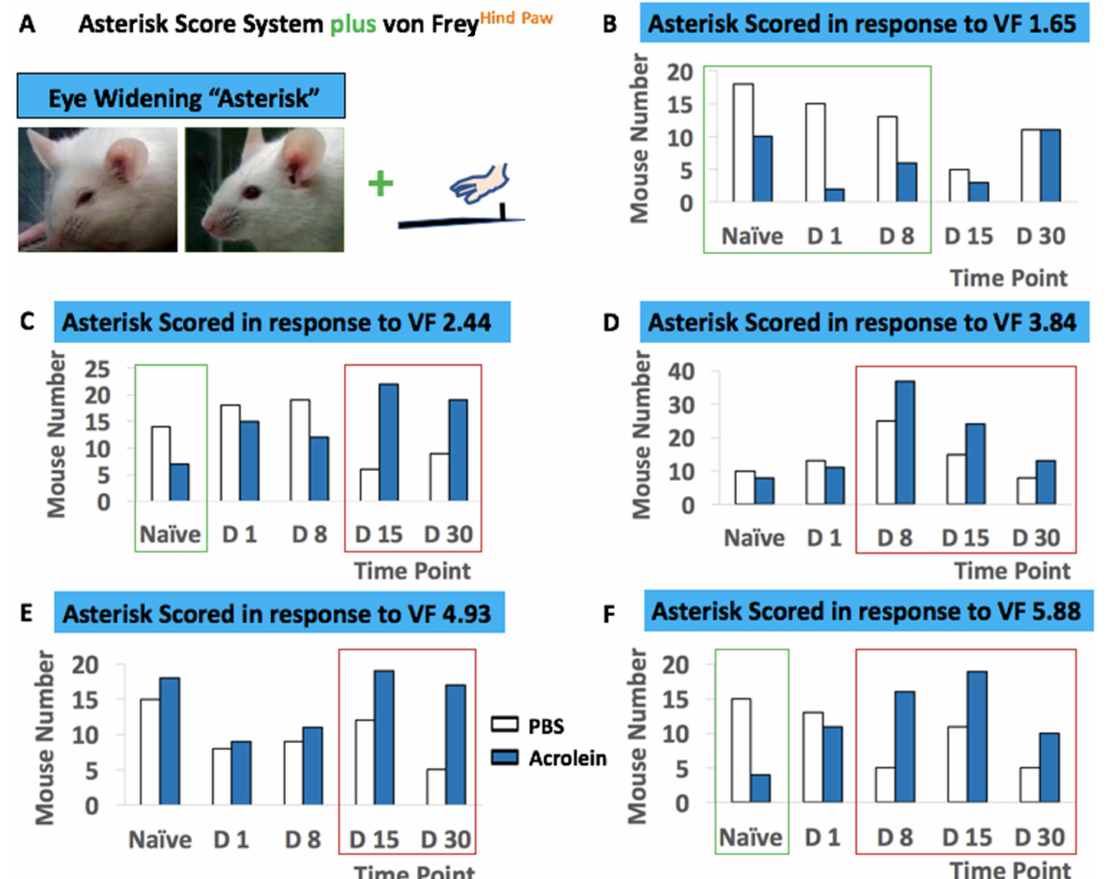
Figure 9. Concurrent assessment of the facial expression of pain and mechanical allodynia shown in PBS vs. acrolein mice on the time points of naïve, days 1, 8, 15 and 30 as determined by the asterisk scoring system and the application of von Frey filaments to the hind paw. ( A ) Description of the asterisk scoring system with a combination of von Frey application to the pelvic area. The number of responses (bar graphs) and mice that scored an asterisk in response to the application of von Frey filaments 1.65 ( B ), 2.44 ( C ), 3.84 ( D ), 4.92 (graph says 4.93, should be 4.92) ( E) and 5.88 ( F